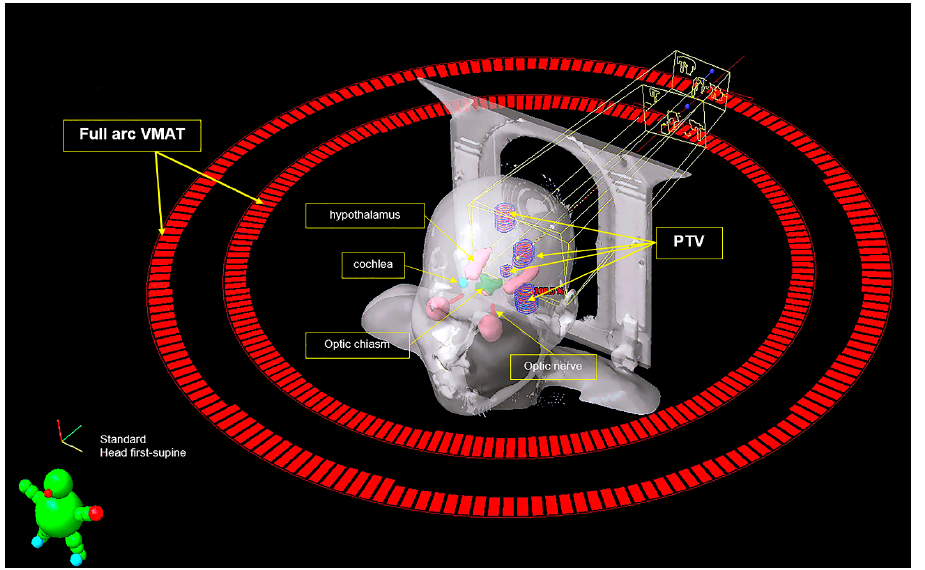
Figure 1. Fractionated VMAT treatment for brain oligometastases. Table 2. Dose constraint for normal organs-at-risk (OAR).